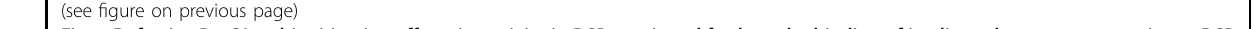
Fig. 4 Defective RecQL4 ubiquitination affects its activity in DSB repair and furthers the binding of its direct downstream proteins to DSB sites. A , B RecQL4 depletion signi fi cantly decreased the HR- and NHEJ-mediated DSB repair in U2OS cells quanti fi ed by DR-GFP and EJ5-GFP reporter system, respectively. The defective DSB repair was signi fi cantly restored by re-introduction of wild-type RecQL4 but not its mutant. The percentage of GFP-positive cells was quanti fi ed by Flow cytometry. The data represent mean ± SEM from three independent experiments. (* p < 0.05, Student ’ s t test). C Analysis of the time-dependent recruitment of various DSB repair proteins in U2OS cells after micro-point laser treatment. Cells were transfected with GFP-tagged RecQL4, RNF8, Ku80, 53BP1, or mCherry-tagged MDC1 plasmids, followed by the treatment of micro-point laser. The images were captured using time-lapse microscopy. At least 15 cells for each transfection were recorded and analyzed for the earliest time point of protein aggregate formation at DSB track. D RecQL4 ubiquitination status affects the recruitment of its directly associated downstream protein-CtIP. RecQL4 was fi rst silenced in U2OS cells followed by transfection with GFP-tagged CtIP and mCherry-tagged wild type RecQL4 or its mutant (3M). The mCherry-positive cells were treated with micro-point laser and the images were captured using microscopy. Both recruitment time and fl uorescence density were recorded and at least 15 cells were analyzed. The data represent mean ± SEM from three independent experiments. ** p < 0.01. E RecQL4 3M mutant interferes with its capacity in processing ssDNA formation at DSB ends estimated by an end resection assay. RecQL4 was fi rst silenced by shRNA infection in U2OS cells which were then transfected with either a control, RecQL4 WT, or 3M mutant for 24 h, followed by the treatment with 1 μ M CPT (C9911, Sigma) for 1 h. Cells were fi xed for RPA2 (ab2175, Abcam) immunostaining. A total of 200 cells were analyzed and RPA2-foci (>15) positive cells were scored for each individual experiment. Data represent mean ± SEM of three independent experiments (** p < 0.01, the Single Factor Anova test). Fluorescence images were captured using a LEICA TCS SP8 confocal microscope system. Scale bar, 22 μ